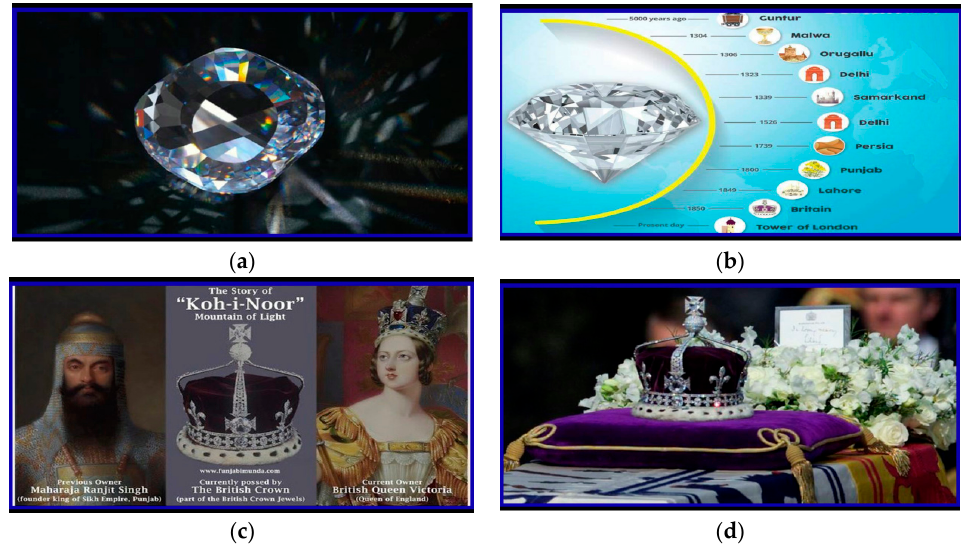
Figure 10. Cover Images ( a ) Image 1, ( b ) Image 2, ( c ) Image 3, ( d ) Image 4.